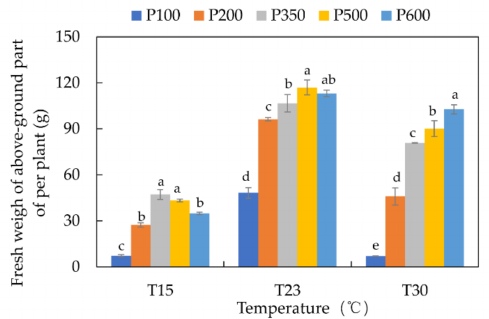
Figure 5. Fresh weight of above-ground part of per plant of lettuce under different temperature and light treatments. Mean values with standard error of mean ( n = 3). Letters indicate significant differences at p < 0.05 according to the LSD